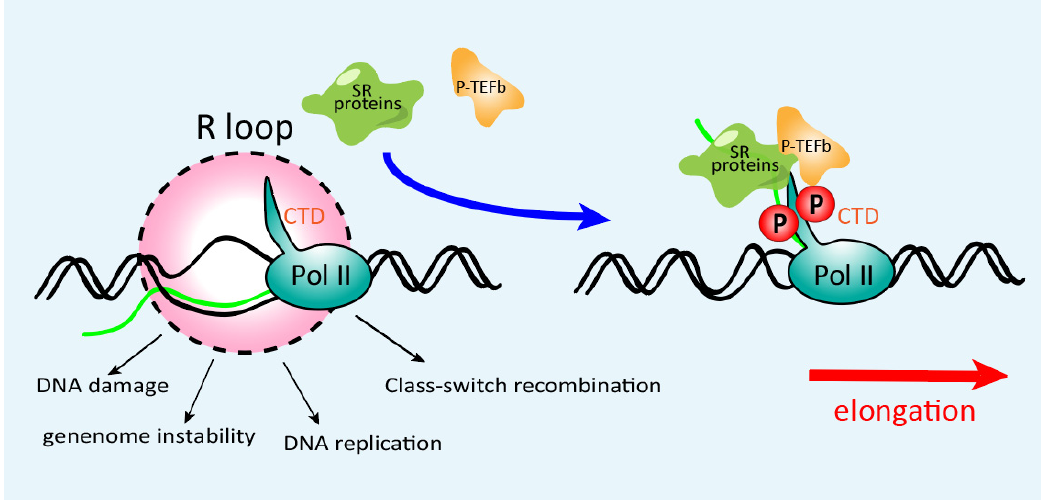
Figure 3. SR proteins in transcriptional elongation and genome stabilization. Through binding to nascent RNA, SR proteins hinder the R-loop formation and dynamically bridge P-TEFb to Pol II, which further catalyzes Pol II phosphorylation in its C-terminal repeat domain (CTD), promoting transcriptional elongation in many genes.